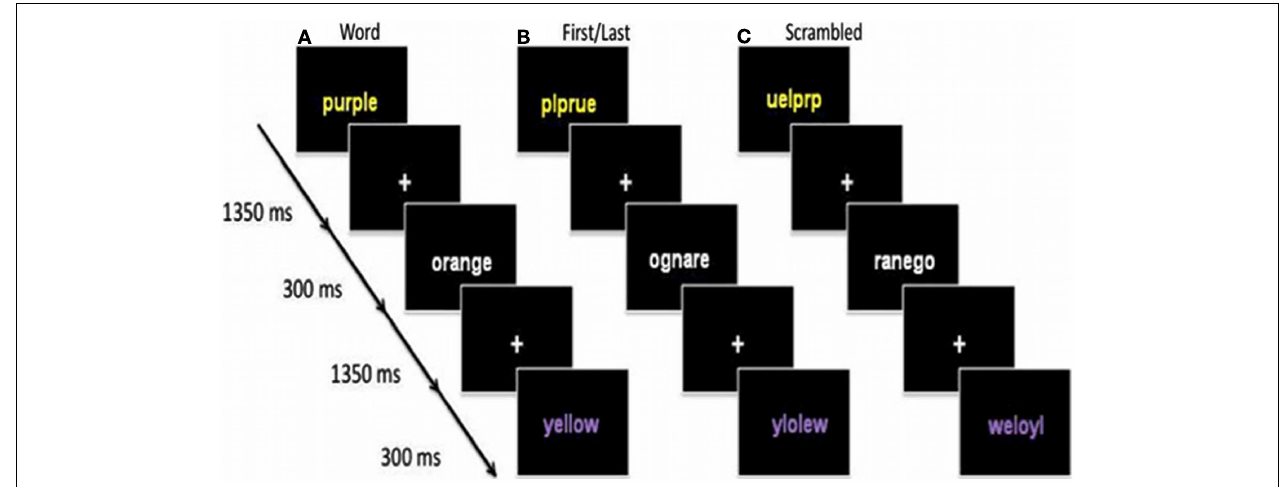
FIGURE 1 | Examples of incongruent stimuli for the three word-types. (A) Incongruent colour words, (B) Incongruent scrambled colour words with the first and last letter in place and (C) Incongruent scrambled colour words.